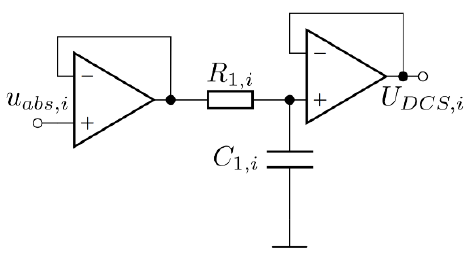
Figure 9. Measurement averaging circuit.